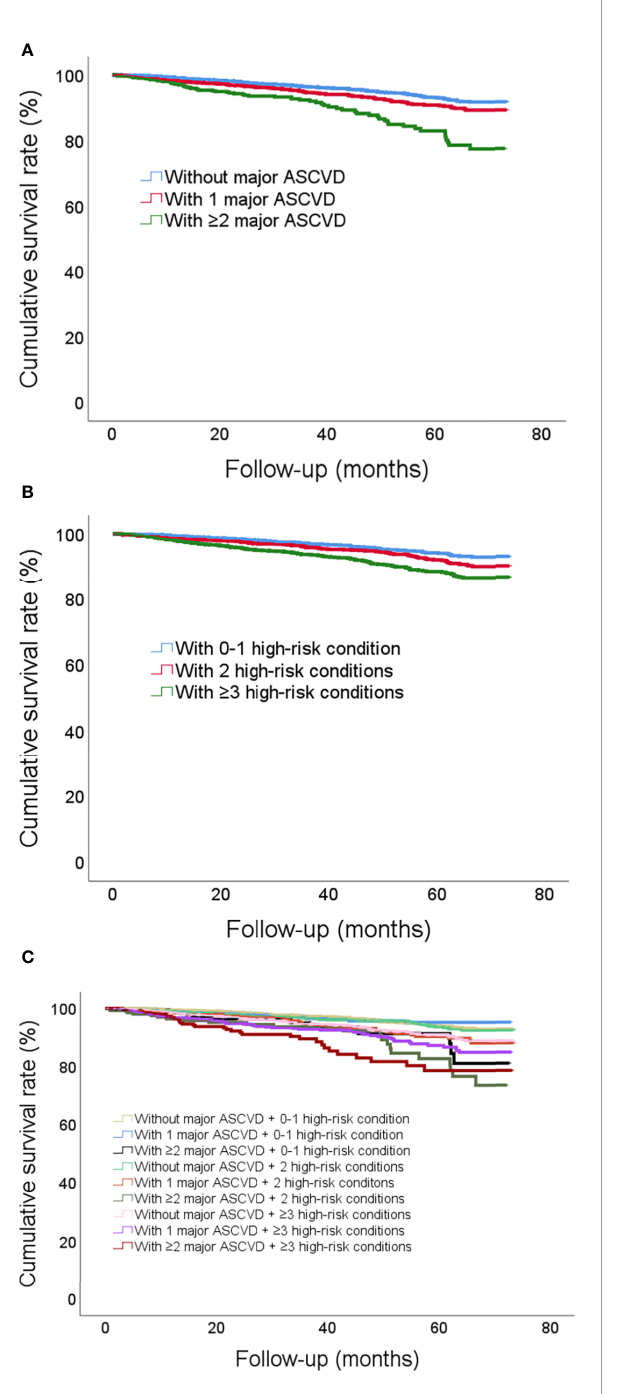
FIGURE 4 | Recurrent event rates (A, B) and hazard ratios (B, C) for a given high-risk condition among different stages of ASCVD. Model 1 was a given high- risk condition with adjustment for age, gender, BMI, prior PCI/CABG, and current smoking. All covariates including the above covariables and high-risk conditions were added simultaneously to Model 2. MASCVD, major atherosclerotic cardiovascular disease; CKD, chronic kidney disease; HF, heart